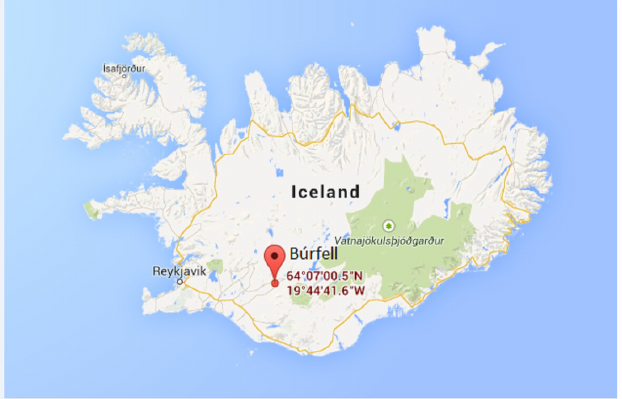
Figure 1. Location of Búrfell in the south Iceland [67].